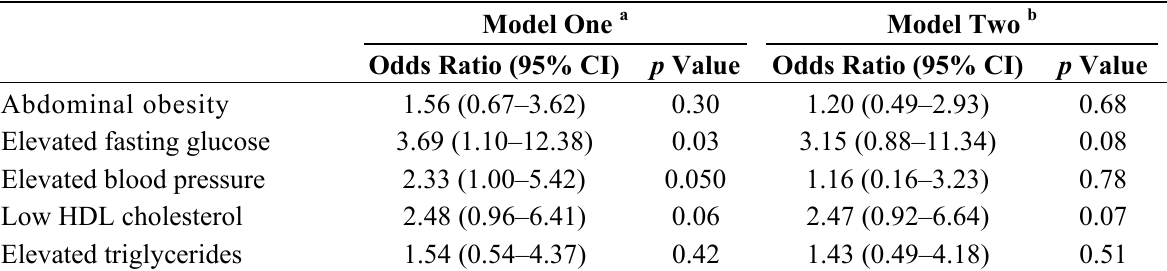
Table 3 . Associations of MetS components with CKD in Group 1.